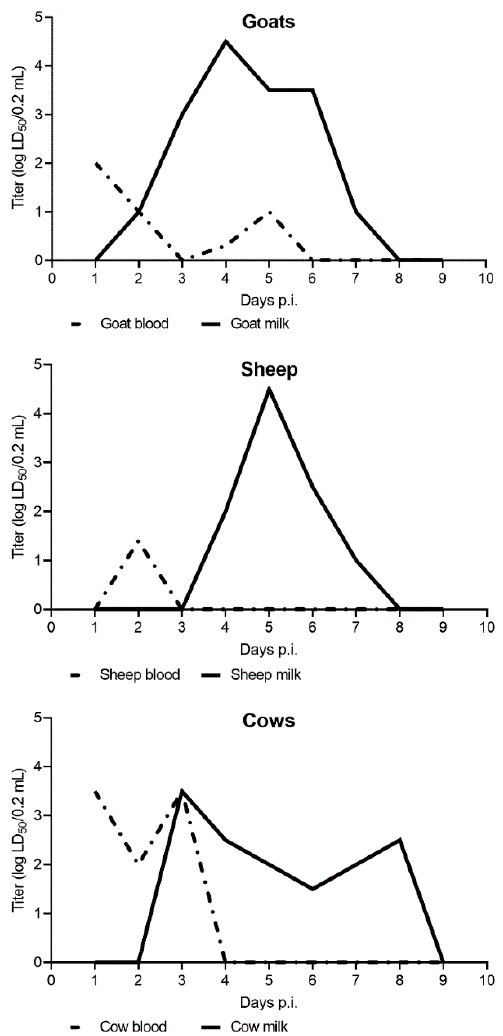
Figure 3. Comparison of TBEV viral titers in milk (full line) and blood (dashed line) of experimentally infected sheep, cows, and goats (adapted from Ref.